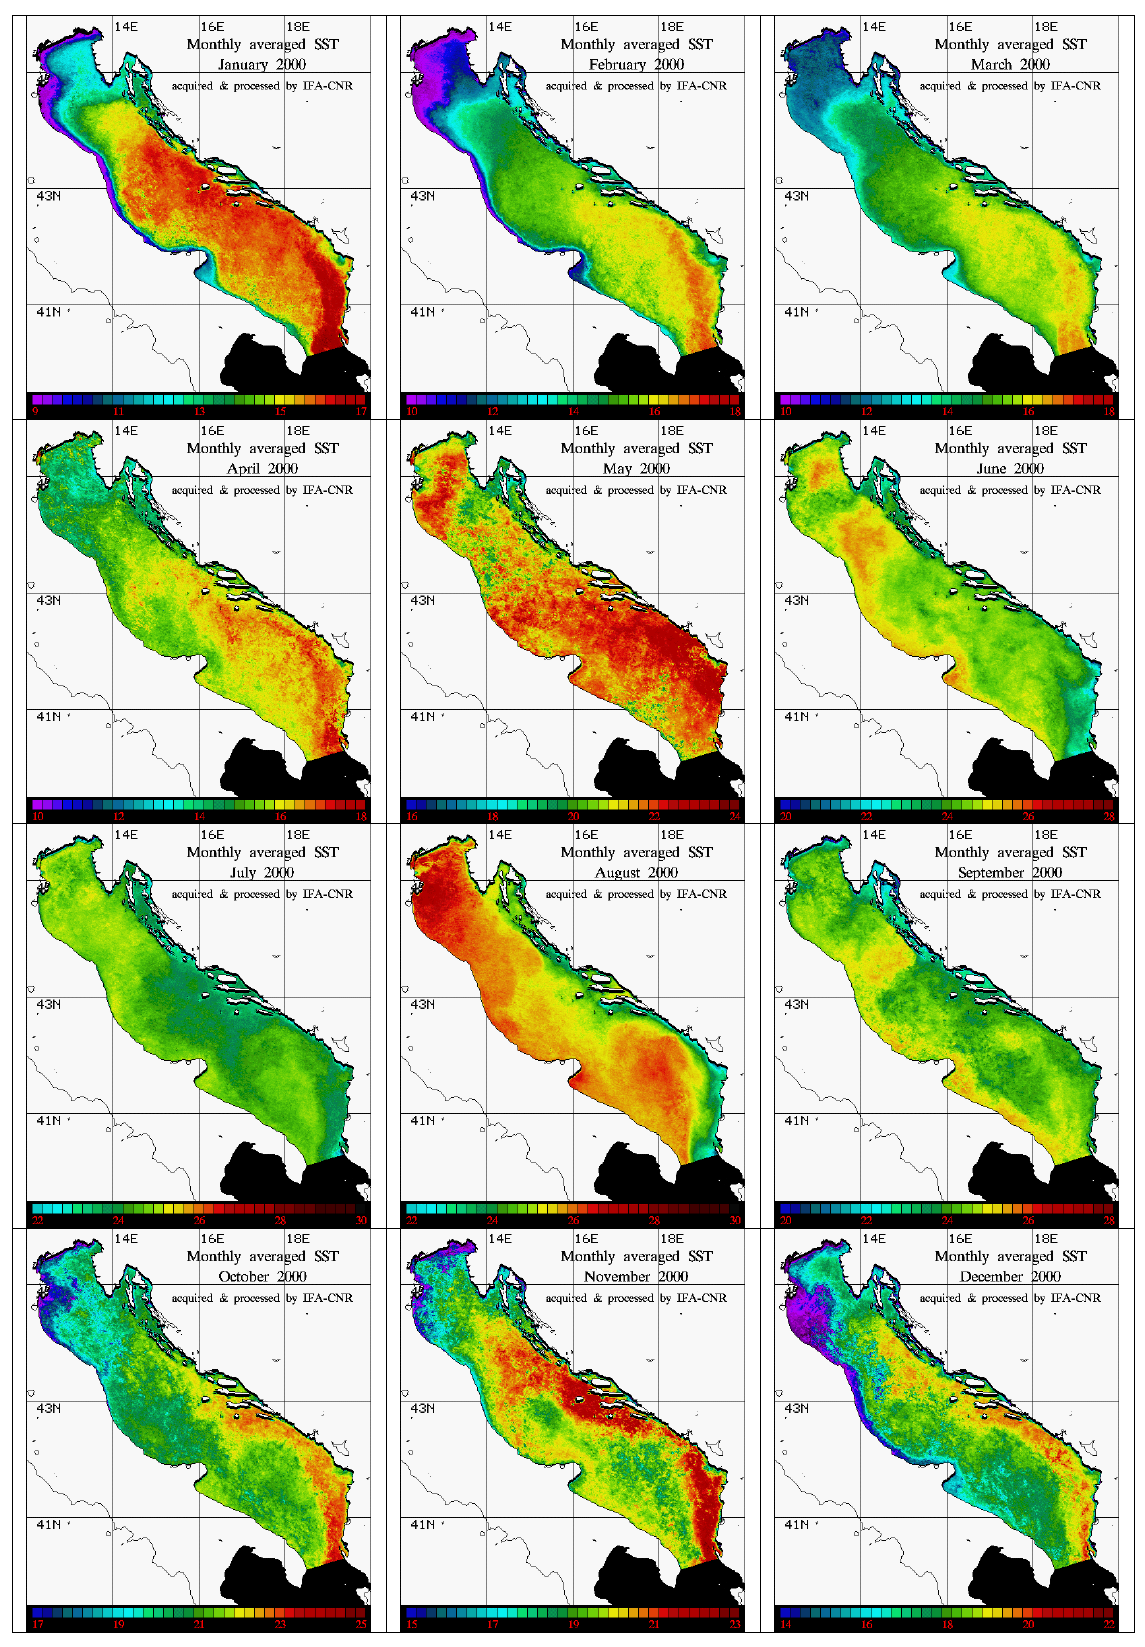
Fig. 2b. Same as Fig. 2a. except for the January – December 2000